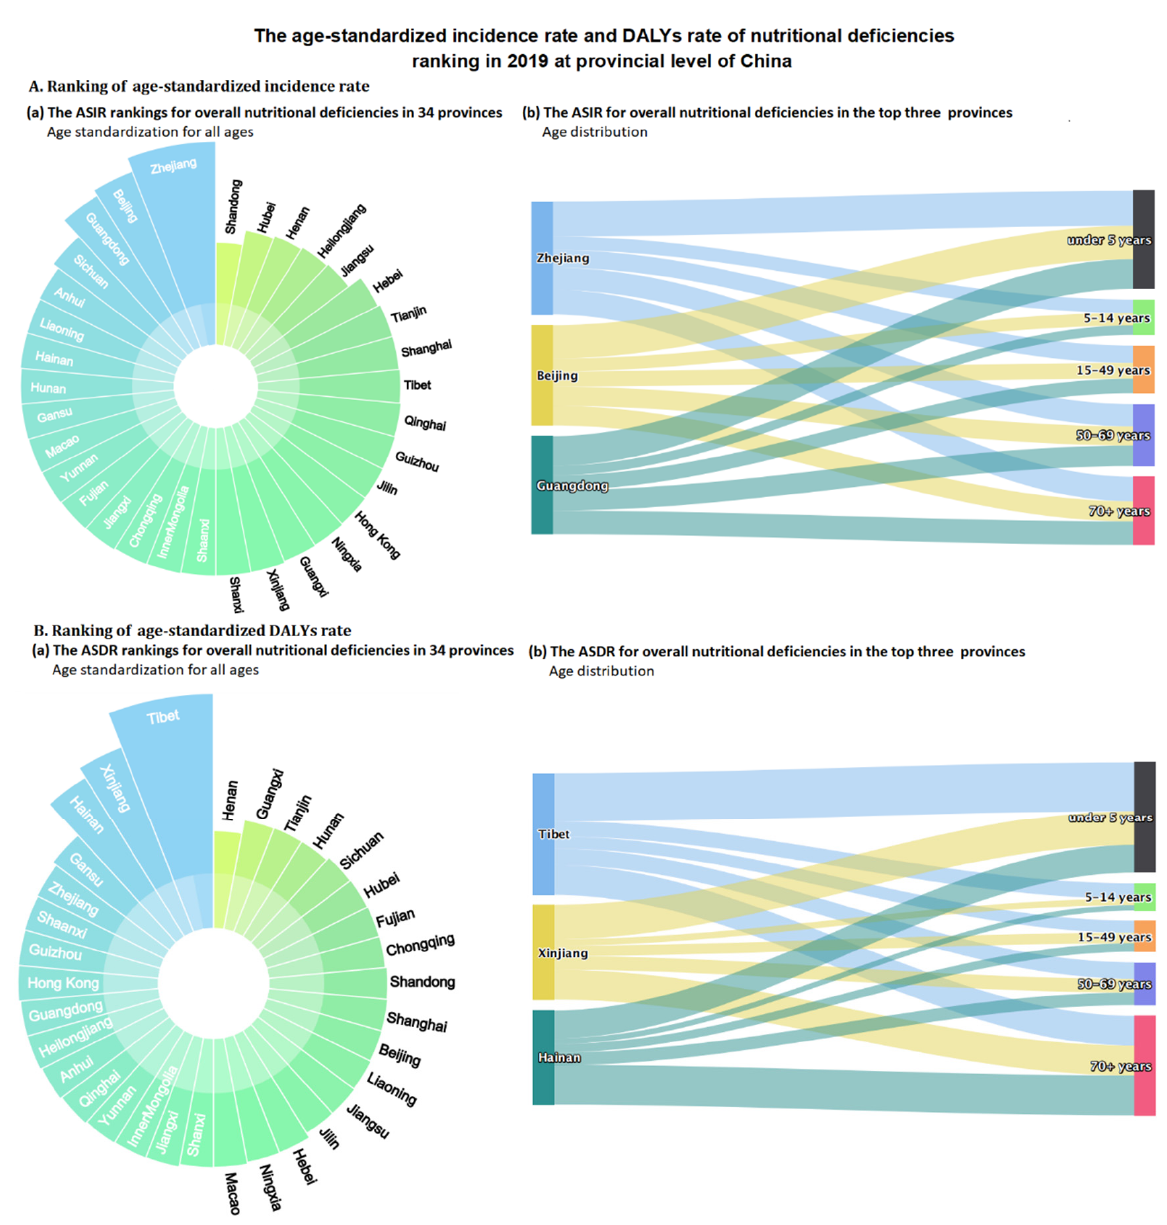
Figure 4. The age-standardized incidence rate and DALYs rate of nutritional deficiencies ranking in 2019 at provincial levels of China. ( A ) Age-standardized incidence rate; ( B ) Age-standardized DALYs rate. DALYs = disability-adjusted life-years.